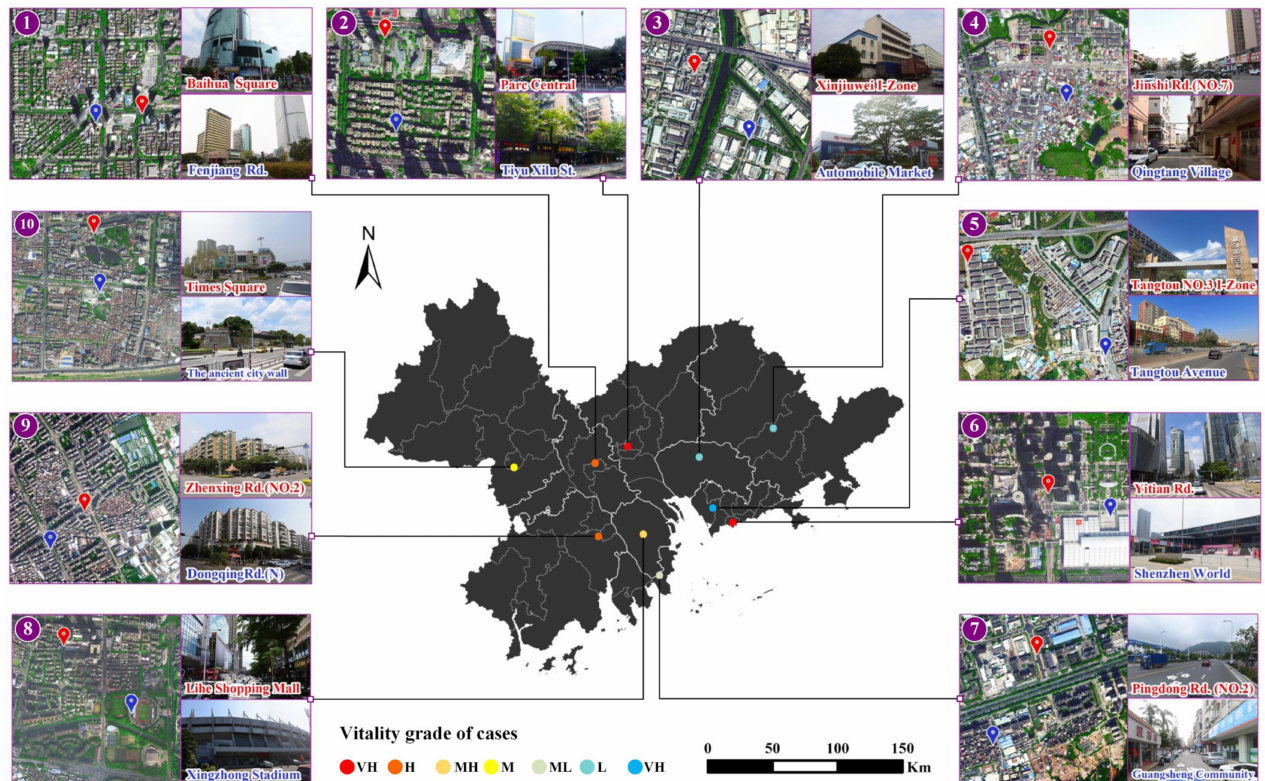
Figure 10. The selected cases with remote sensing images and street